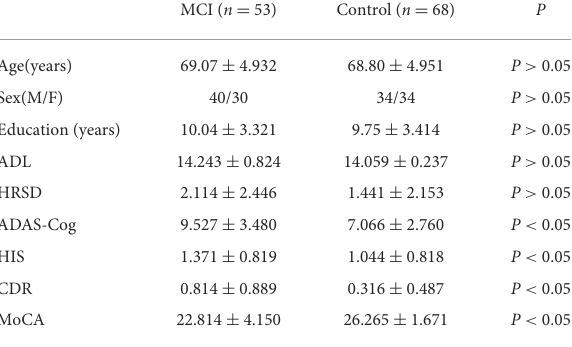
TABLE 1 Demographics of the study population.